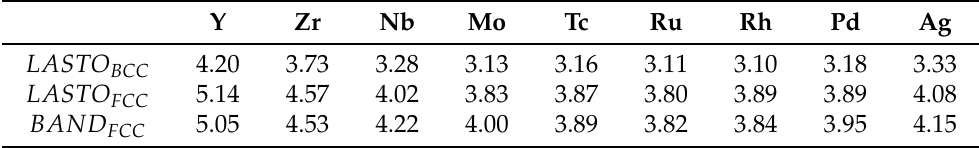
Table A2. Lattice constants in Angstrom.